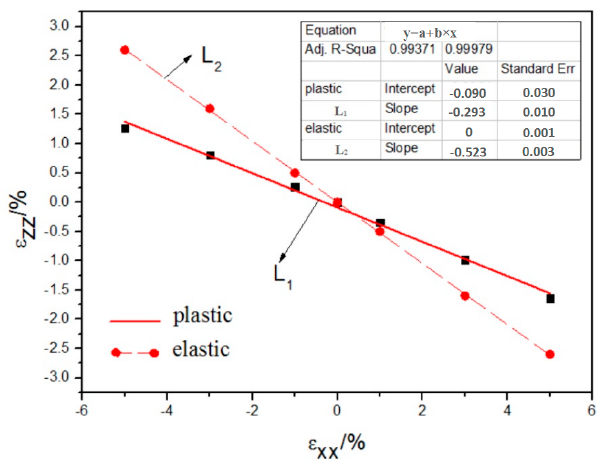
Figure 1. Deviations of out − of − plane strain ε zz of In 0.5 Al 0.5 N after different deformations of biaxial strain.